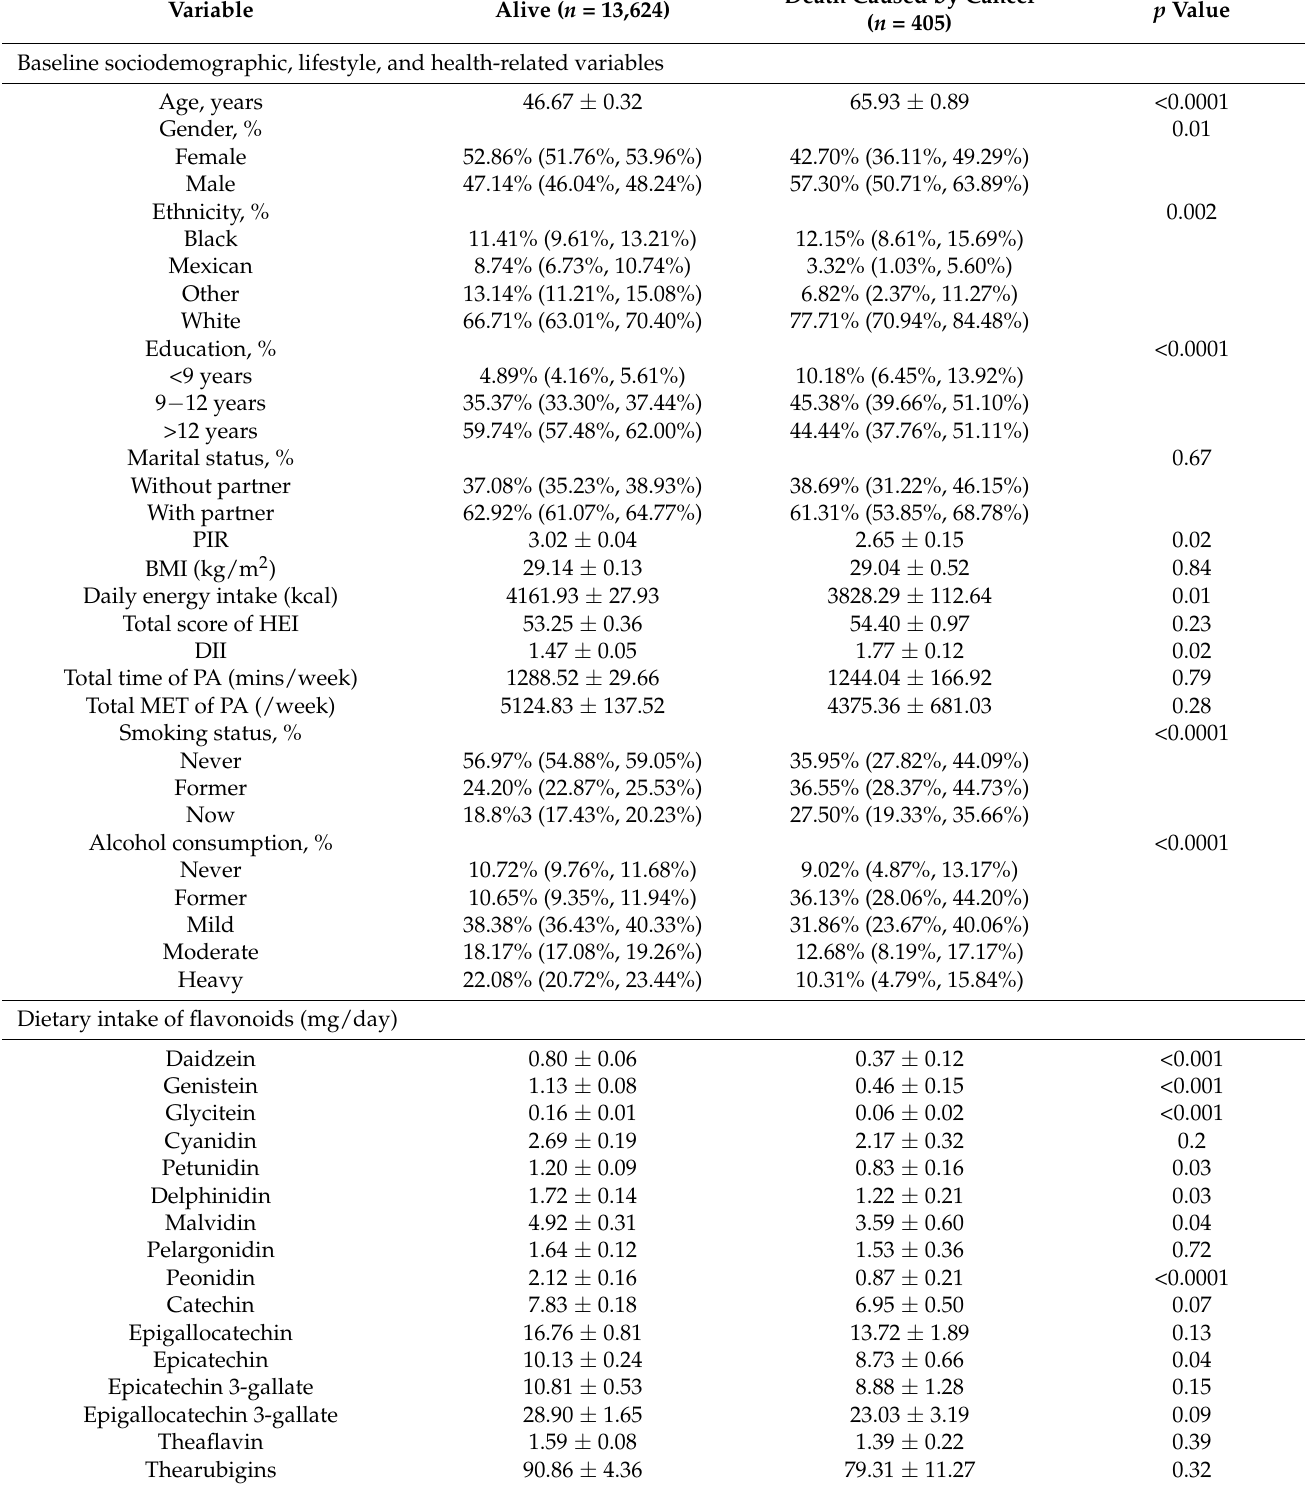
Table 2. Characteristics of participant by living status, NHANES 2007-2010, 2017-2018